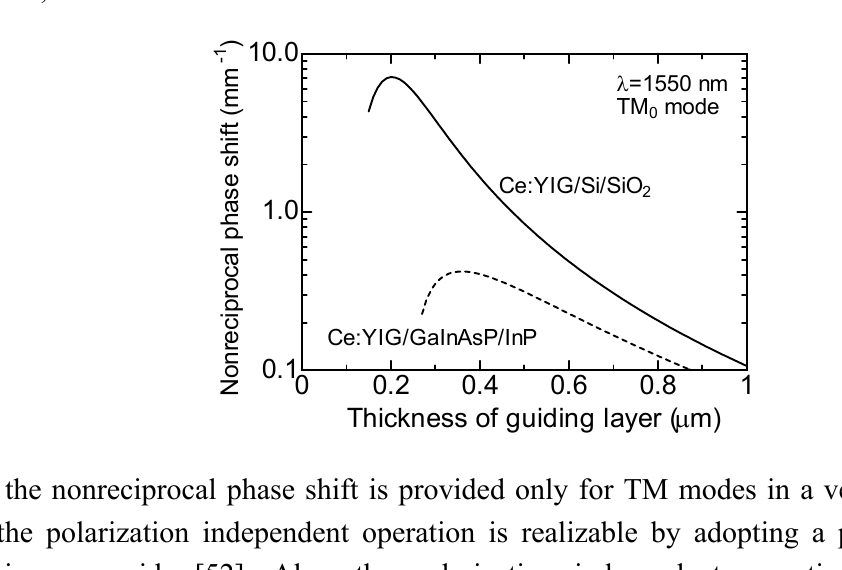
mode propagating in Ce:YIG/Si/SiO 0